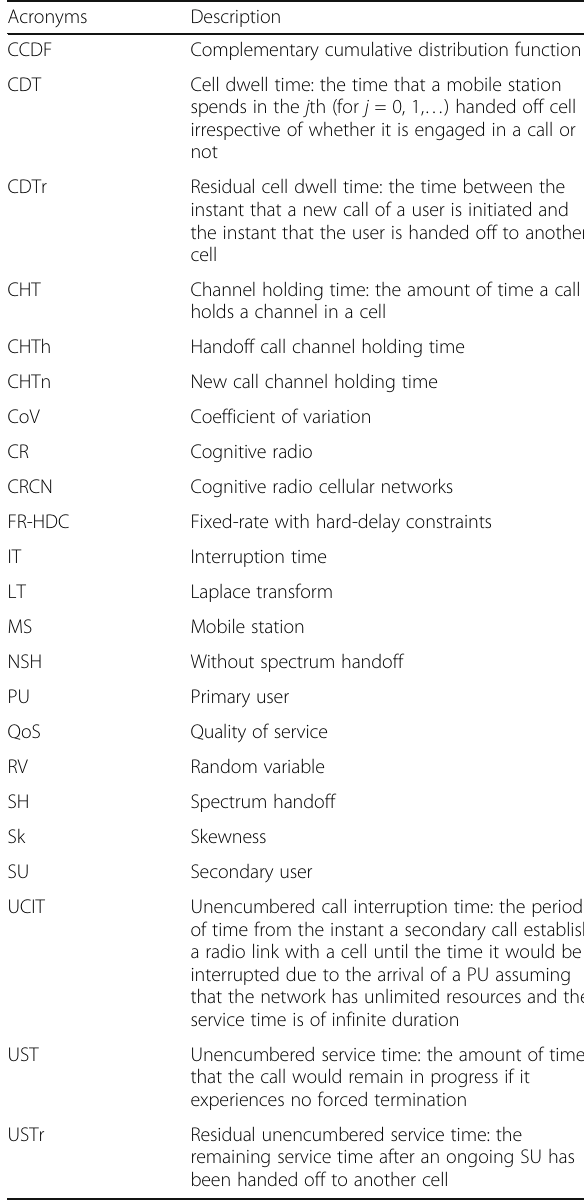
Table 1 List of acronyms